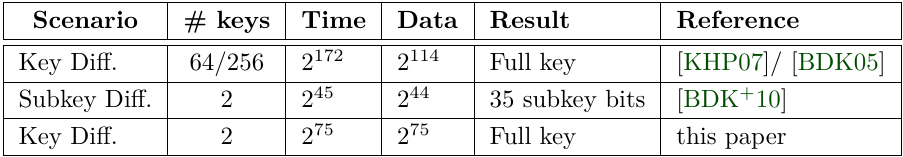
Table 1: Summary of attacks on 10-round AES